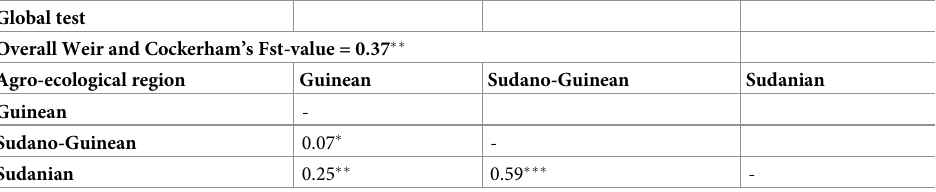
Table 8. Results of pairwise Fst analysis among agro-ecological regions of Kersting’s groundnut accessions. Global test